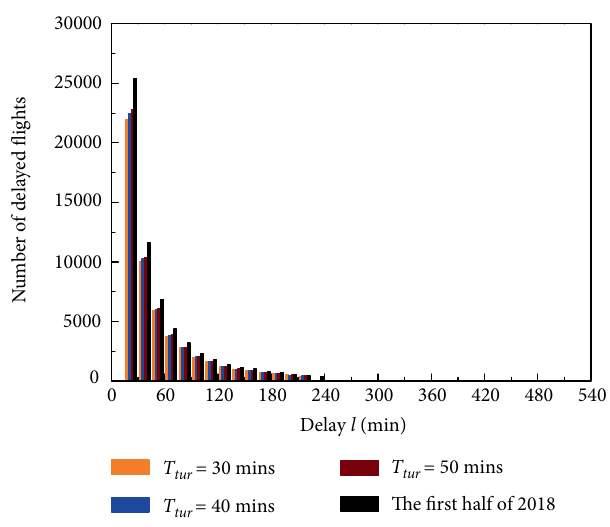
Figure 6: Comparison of the number of delayed flights before and after adjusting flight